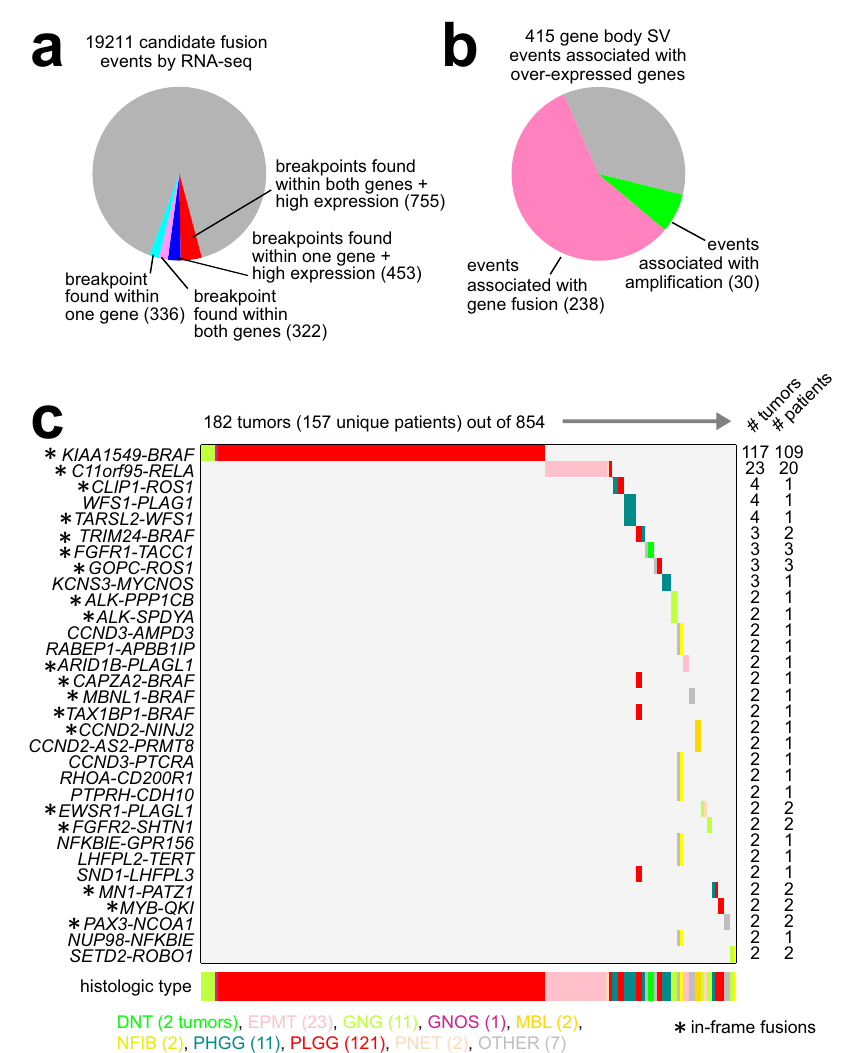
Fig. 4 Identi fi cation of gene fusion events by both RNA-seq and SSVs. a Out of 19,211 candidate fusion events identi fi ed by RNA-seq analysis (using Arriba or STAR-fusion algorithms), numbers of events with support from SSV analyses. As indicated, for 1866 candidate fusion events, SSV breakpoints were found within one or both genes, with or without a high expression association (see Methods). b Of the 415 gene body SSV breakpoint events associated with overexpressed genes (70 genes with FDR < 10% correcting for tumor type and CNA), the fractions of events associated with either gene fusion by combined RNA-seq and SSV analysis or high-level gene ampli fi cation are indicated. c Gene fusions with both RNA-seq and SSV support with high expression association, and involving either greater than two tumors ( KCNS3 - MYCNOS , TARSL2 - WFS1 ) or greater than one tumor plus a COSMIC gene 20 are represented. Tumor type is indicated along the bottom and in the coloring of the fusion